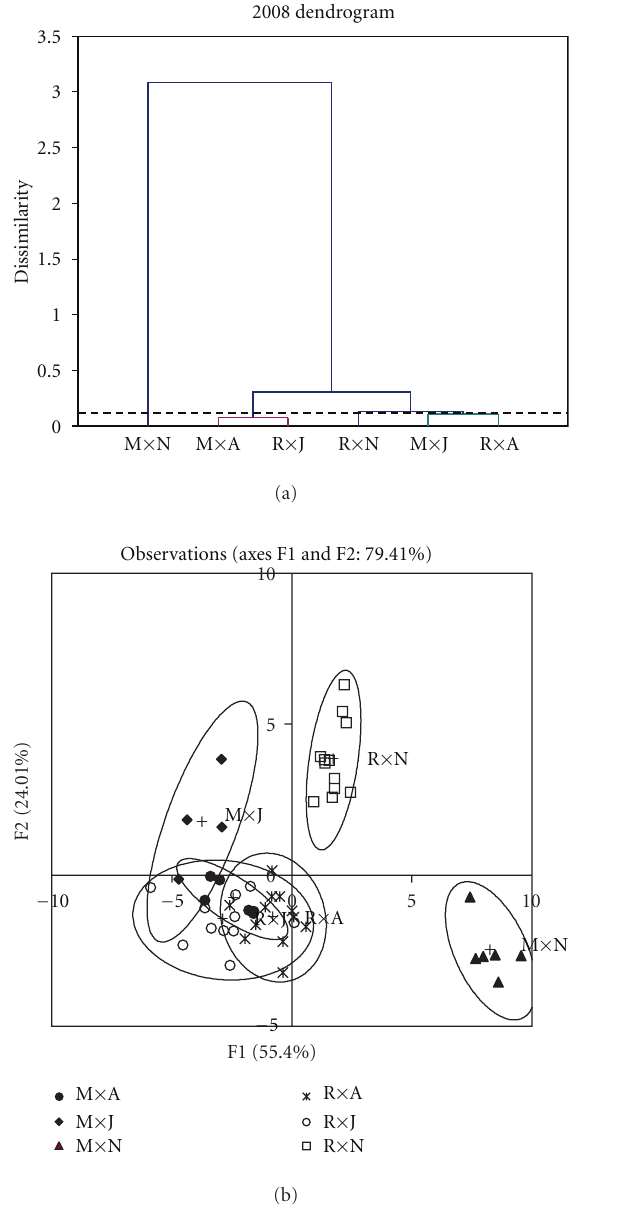
Figure 11: Results of cluster analyses conducted during 2008 on the community level physiological profiles of the soils, as measured using the Biolog EcoPlate method (a) dendrogram and (b) discriminant analysis (DA) (M = monoculture and R = rotation, J = June, A = August, and N = November).